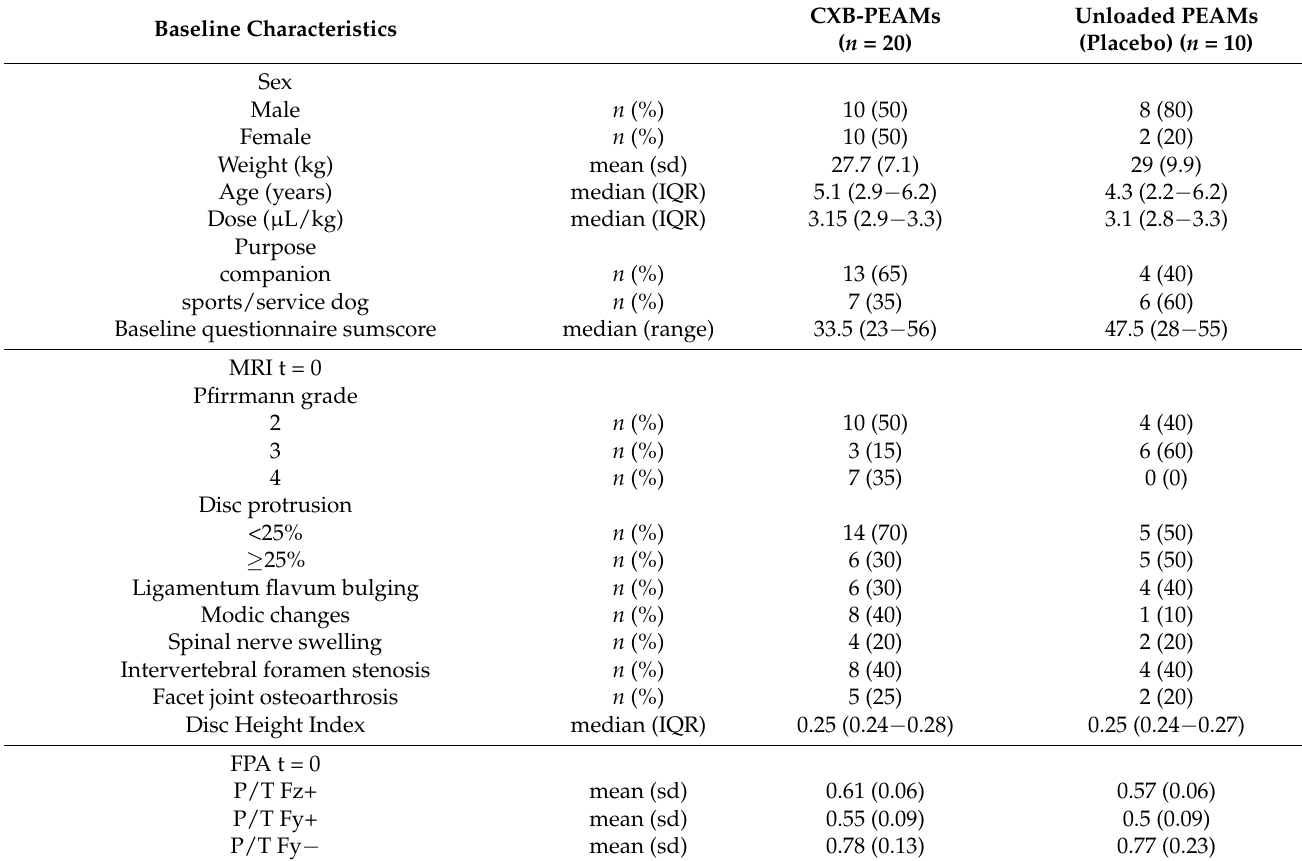
Table 2. Baseline characteristics of 30 dogs with degenerative lumbosacral stenosis, treated with intradiscal injection of celecoxib-polyesteramide microspheres (CXB-PEAMs) ( n = 20) or unloaded PEAMs (placebo, n =